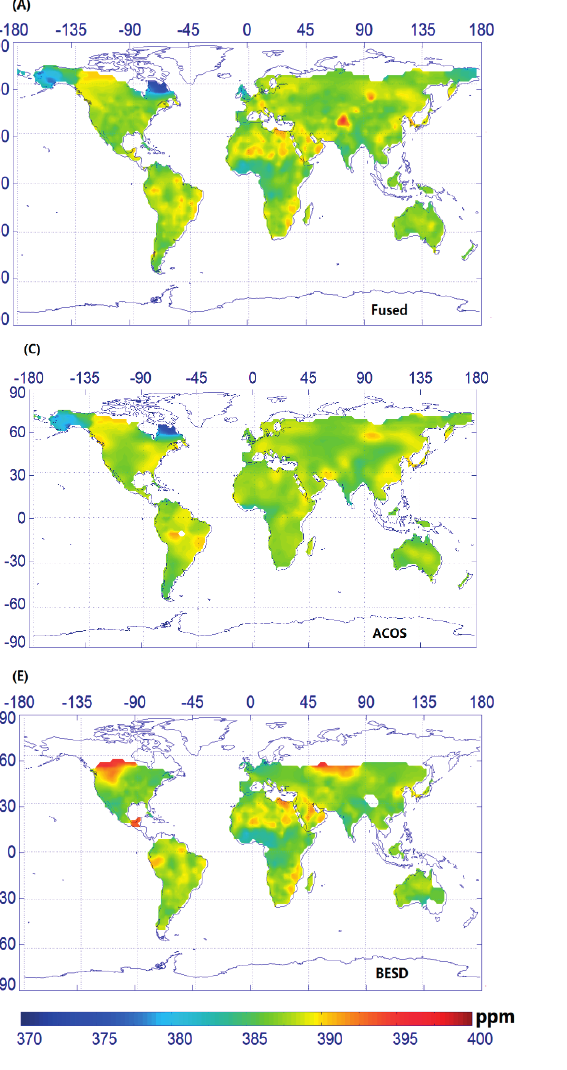
Figure 4. Comparison of the spatial distribution of the Kriging predictions and associated standard deviations: ( A ) Interpolated fused CO data; ( B ) Standard deviation in (A); 2 data; ( D ) Standard deviation in (B); ( E ) Interpolated BESD ( C ) Interpolated ACOS CO 2 CO data; and ( F ) Standard deviation in 2